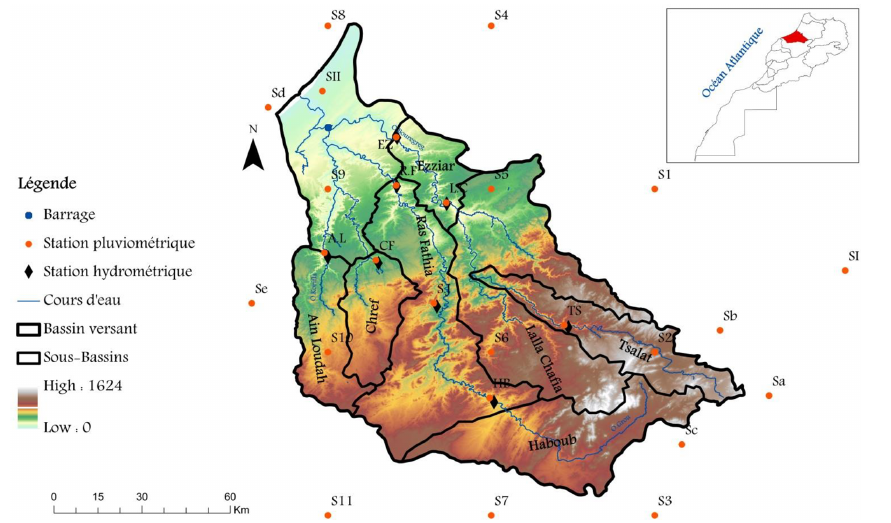
Figure 1. Le bassin versant du Bouregreg et les principaux sous-bassins.